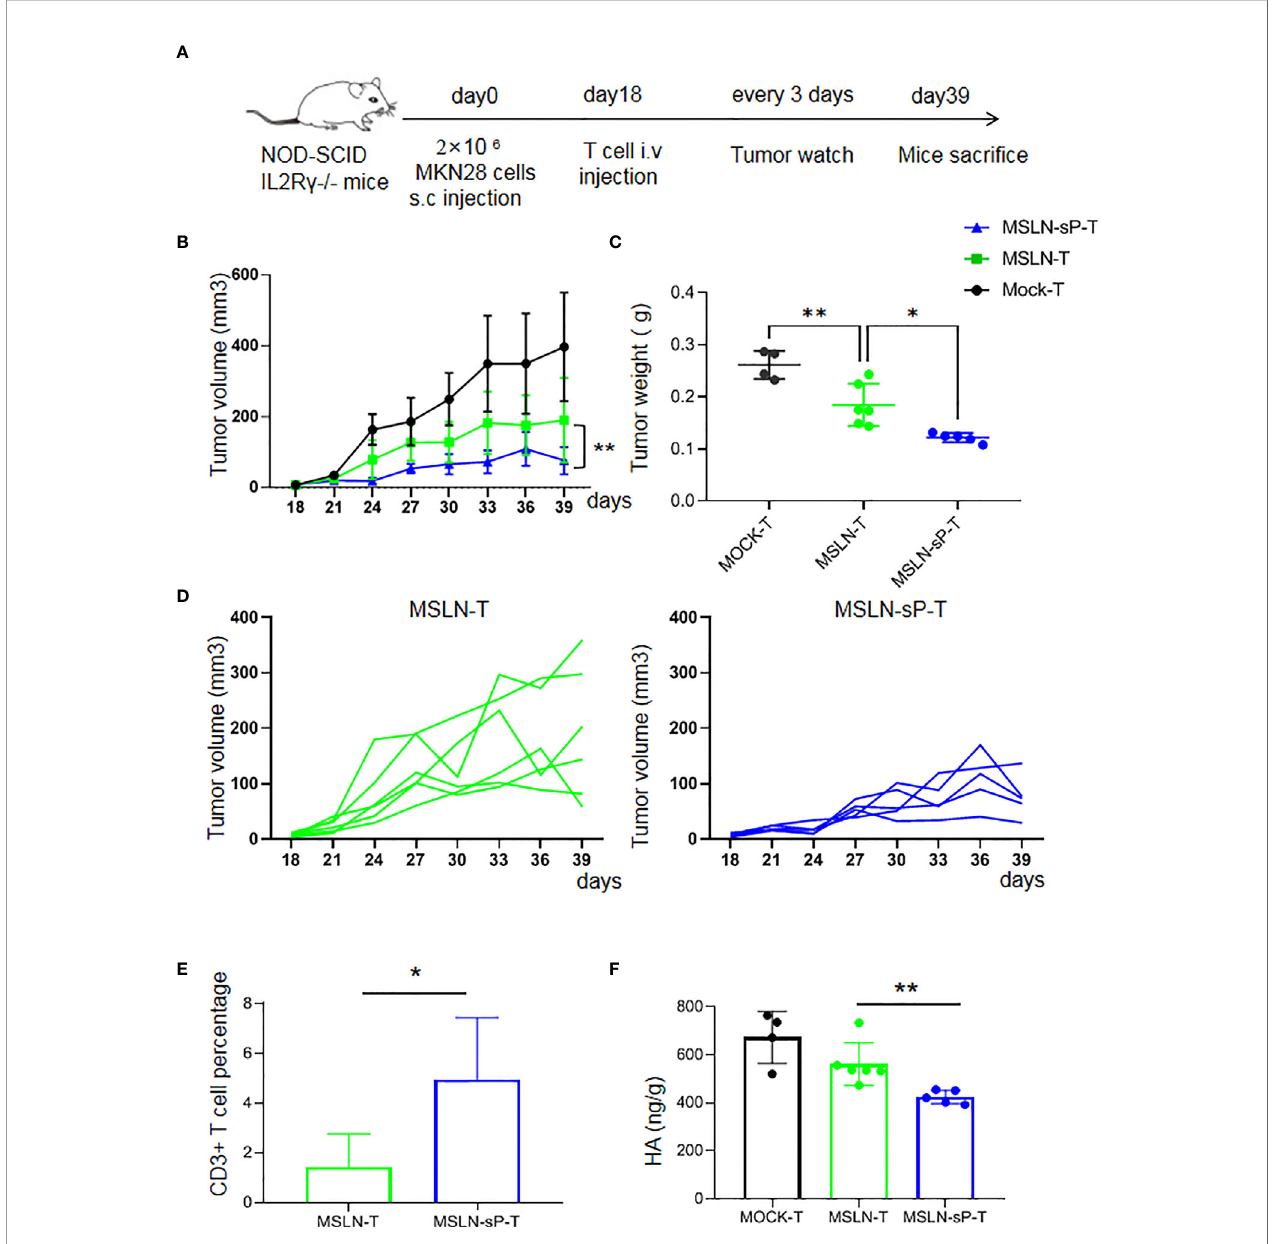
FIGURE 5 | sPH20-IgG2 enhances the in fi ltration and antitumor activity of anti-MSLN CAR-T cells in MKN28 gastric cancer mouse model. (A) Schematic diagram of the experiment, n=4 for Mock-T, n=6 for MSLN-T and n=5 for MSLN-sP-T group. (B) Measurement of tumor volumes after treatment with Mock-T, anti-MSLN-T or anti-MSLN-sP-T cells; (C) Tumor weights of the Mock-T, anti-MSLN-T and anti-MSLN-sP-T cell groups on day 39 after tumor injection (time of sacri fi ce). (D) Tumor growth curves for the individual mice in the anti-MSLN-T and anti-MSLN-sP-T cell groups. (E) Statistical analysis for the percentage of T cells in the tumor tissues of the anti-MSLN-T and anti-MSLN-sP-T cell treated groups. (F) ELISA detection of HA level in the in the tumor tissues of the anti-MSLN-T and anti-MSLN-sP-T cell treated groups. Error bars denote the S. D, and the results were compared with an unpaired t test. *P<0.05;